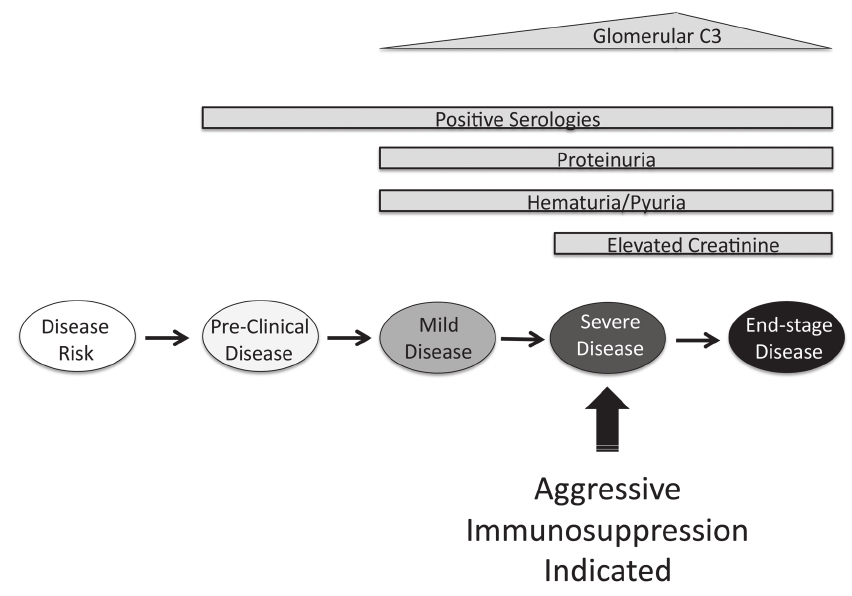
Figure 2. Treatment paradigm for lupus nephritis. Ideally, aggressive immunosuppression is reserved for those with severe renal dis- ease. Lupus nephritis is associated with the presence of serologic changes, proteinuria, hematuria, and elevated serum creatinine